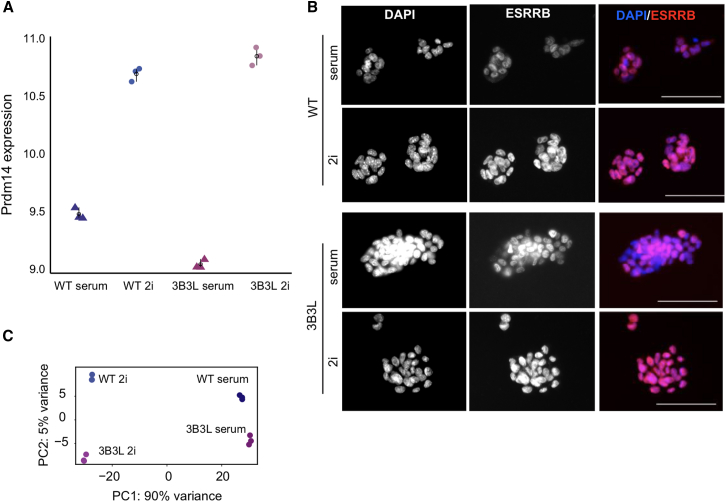
Analysis of the Functional State of 3B3L mESCs in 2i(A) Regularized log (rlog) transformed expression value for Prdm14 in WT and 3B3L cells cultured in serum or 2i. Error bars show mean and bootstrapped 95% confidence intervals for each cell type and treatment group. Data are from three biological replicates(B) ESRRB staining in 3B3L cells under 2i or serum conditions. Nuclei are counterstained with DAPI. Exposure times for the TxRed channel (ESRRB) were matched between conditions. Scale bars represent 100 μm.(C) Principal-component analysis (PCA) of the transcriptome (RNA-seq) of wild-type (WT) J1 and 3B3L mESCs cultured in serum or 2i. Data are from three biological replicates.